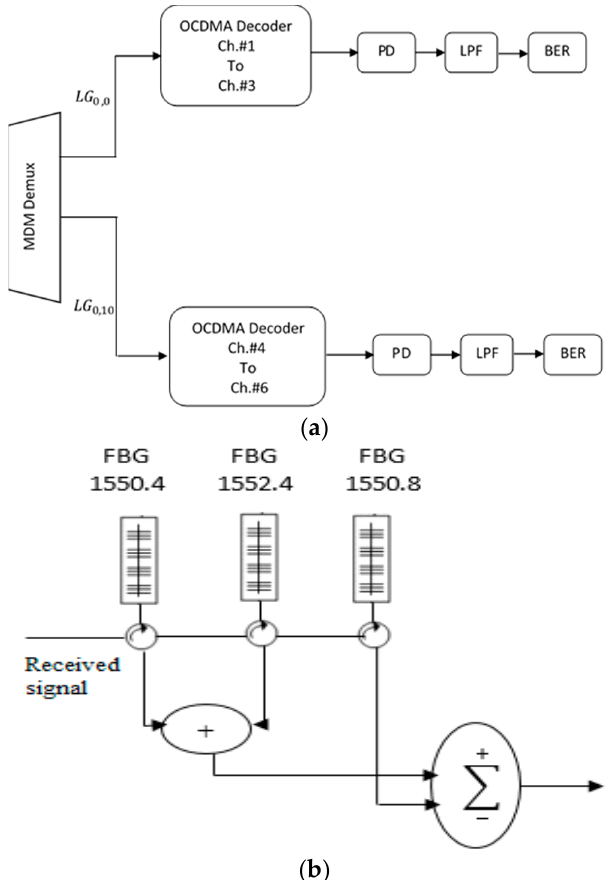
Figure 4. Block diagram demonstrating the receiver of the OAM/OCDMA-FSO system. ( a ) Receiver structure and ( b ) example of OCDMA decoder of user 1.